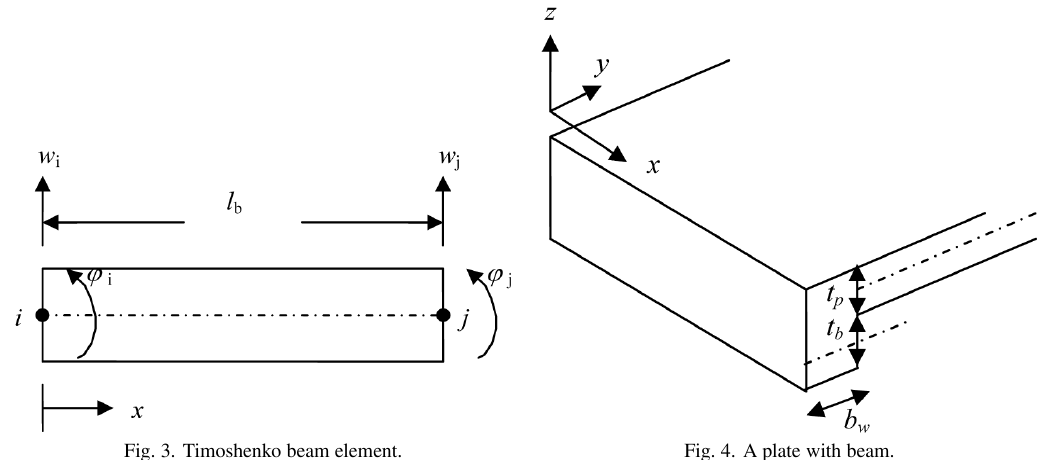
Fig. 3. Timoshenko beam element. Fig. 4. A plate with